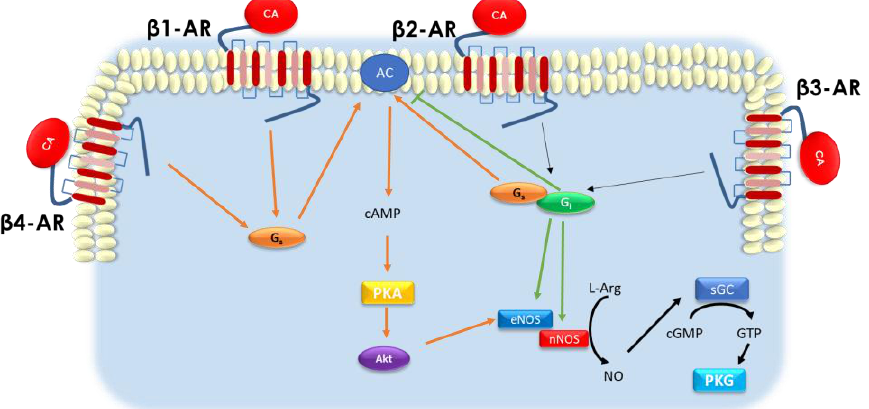
Figure 1. Schematic representation of β -adrenergic receptor (AR)-mediated induction of protein kinase A (PKA) and PKG downstream Gs and Gi protein activation . β 1-, β 2-, β 3-, and the putative β 4-AR are coupled to the stimulatory G proteins (Gs), while only β 2- and β 3-AR are also coupled to the inhibitory G proteins (Gi). Upon ligand binding (catecholamine, CA), Gs proteins activate the adenylate cyclase (AC) on the plasma membrane leading to the generation of Cyclic Adenosine Monophosphate (cAMP), with subsequent activation of PKA, that in turn phosphorylates several key factors, including the PKB (Akt), with the subsequent activation of the endothelial nitric oxide synthase (eNOS). Of note, eNOS activation increases the generation of NO that stimulates the soluble guanylate cyclase (sGC) to produce cGMP and PKG activation. Notably, following the Gi signaling pathway activation, β 2- and β 3-AR can give rise to NO via both eNOS and neuronal NOS (nNOS), thus leading to PKG induction. Gs — pathway in orange; Gi — pathway in green. Black arrows: Gs and Gi pathway.